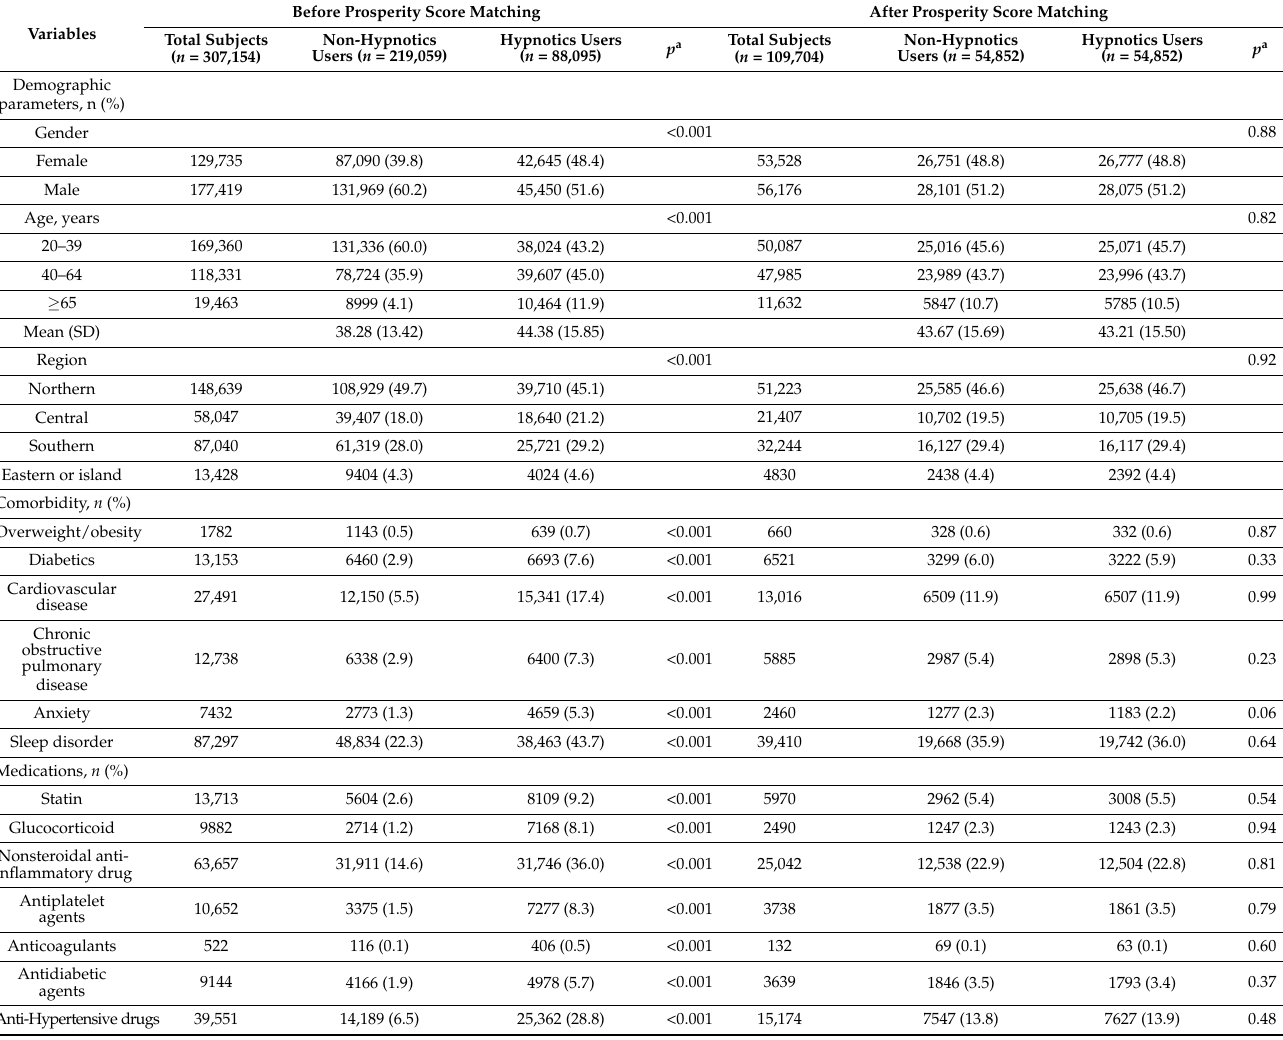
Table 1. Baseline characteristics of included patients with or without prescription of hypnotics before and after prosperity score